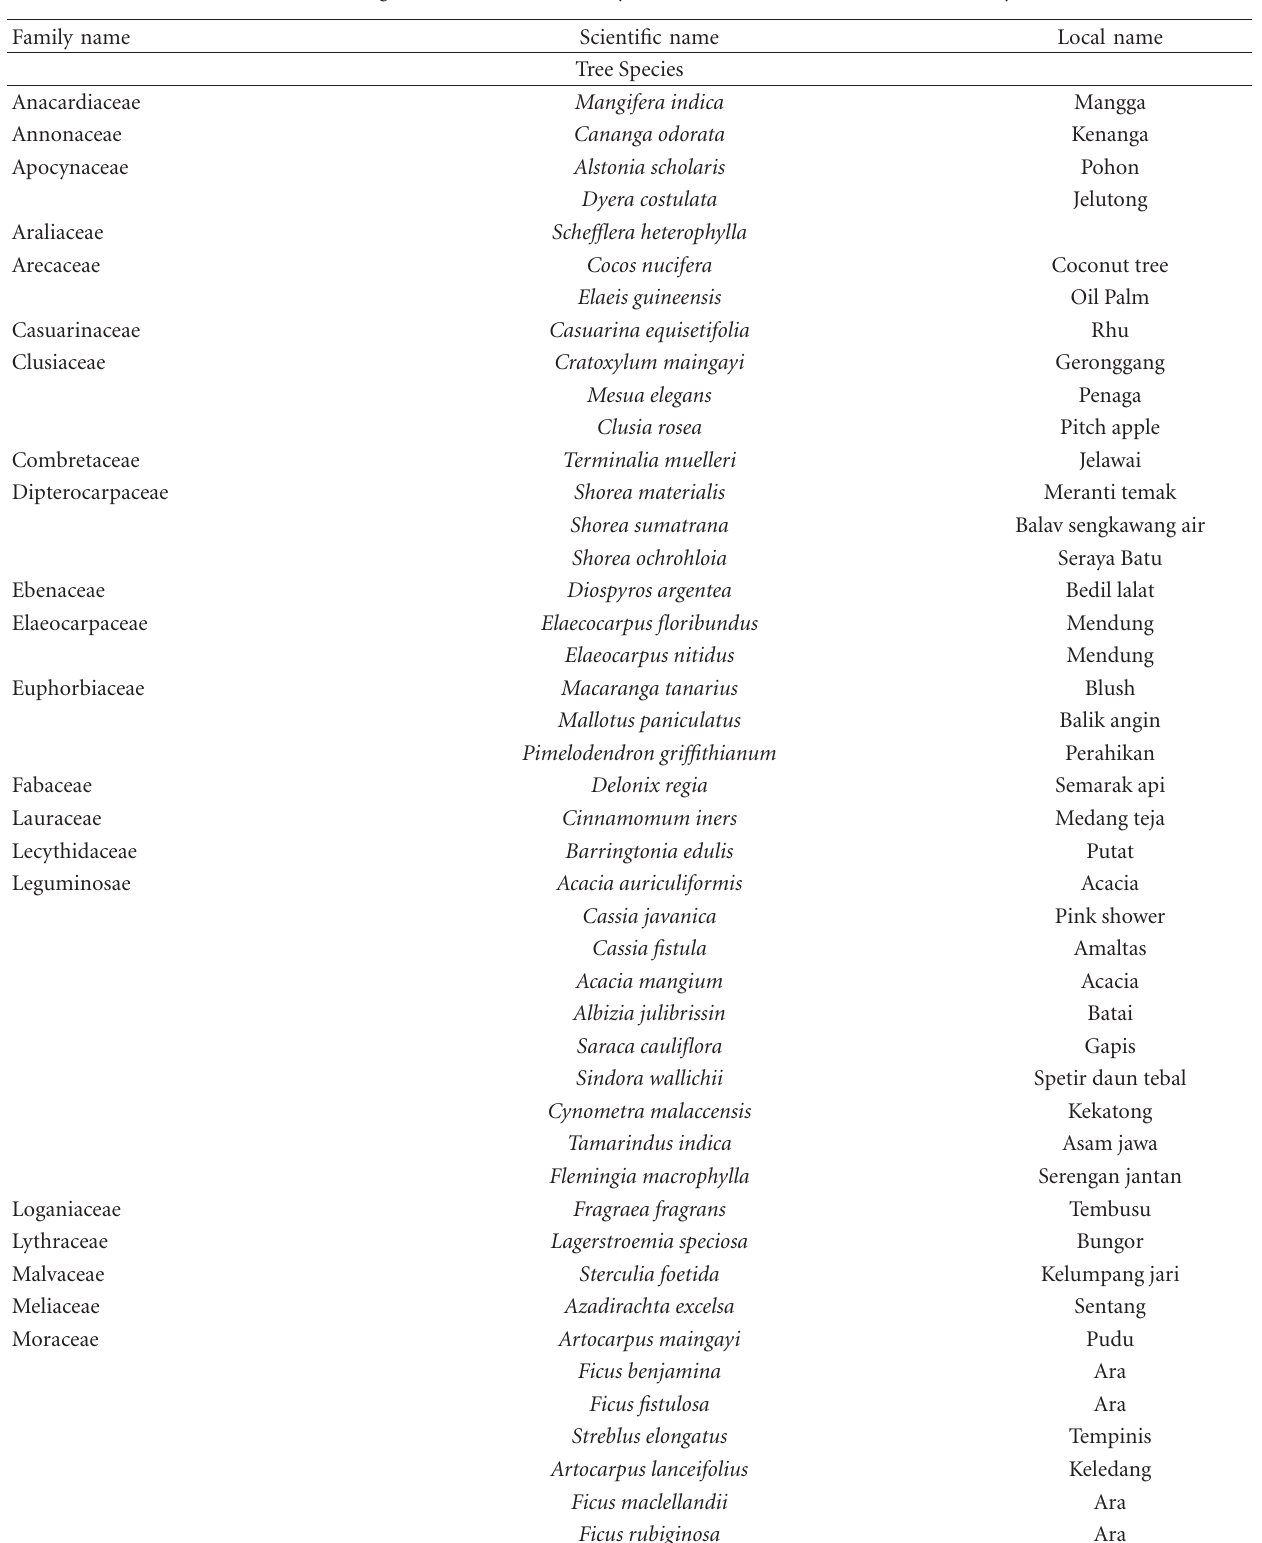
Table 3: List of vegetation recorded at the Paya Indah Wetland Reserve, Peninsular